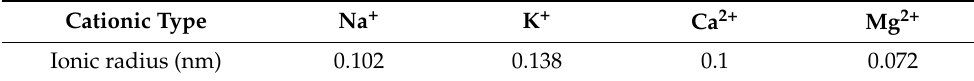
Table 6. Ionic radii of different types of cations.